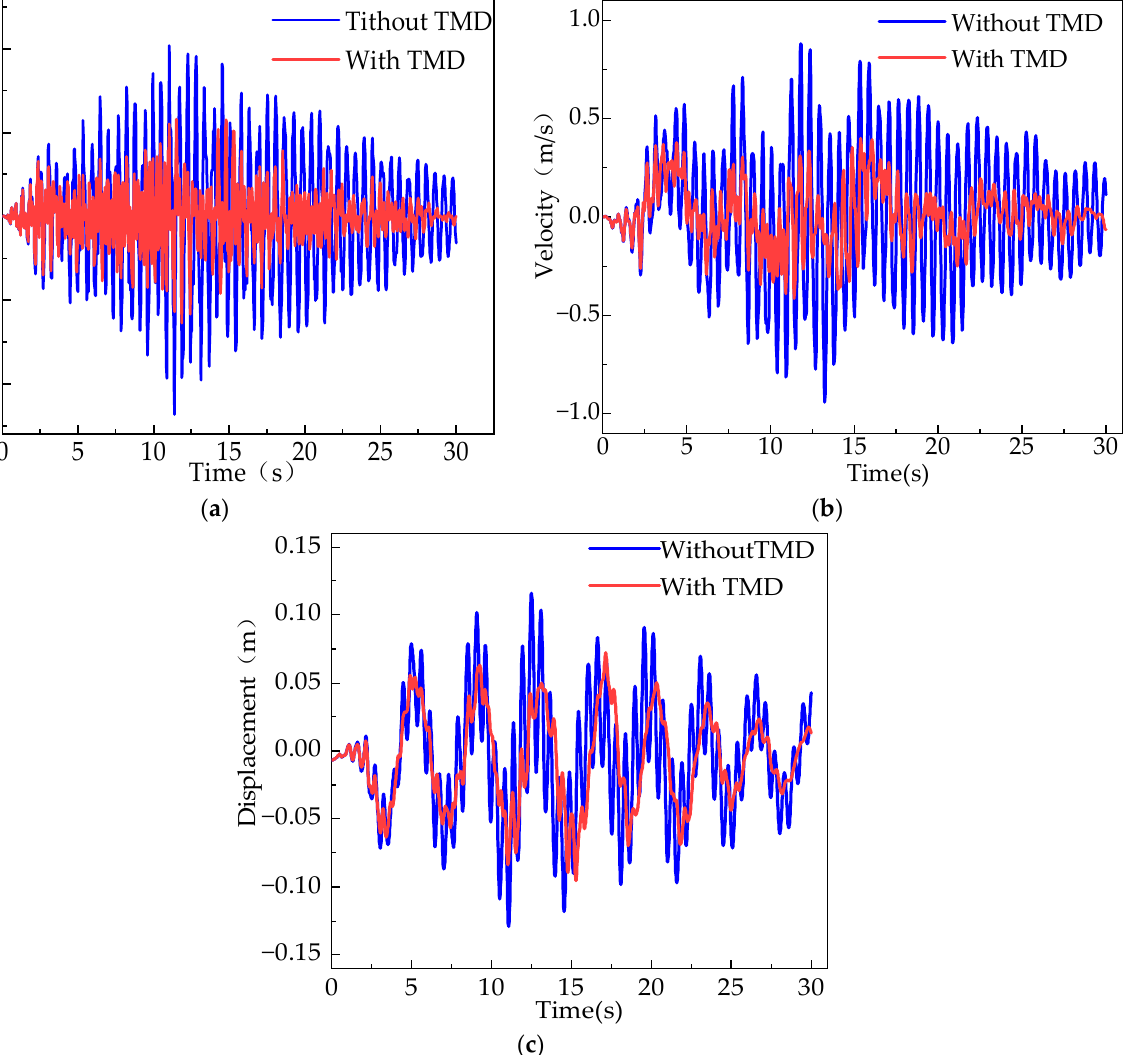
Figure 9. Comparison of acceleration, velocity and displacement at 75 m with and without TMD towers: ( a ) acceleration comparison; ( b ) velocity comparison; ( c ) displacement comparison.